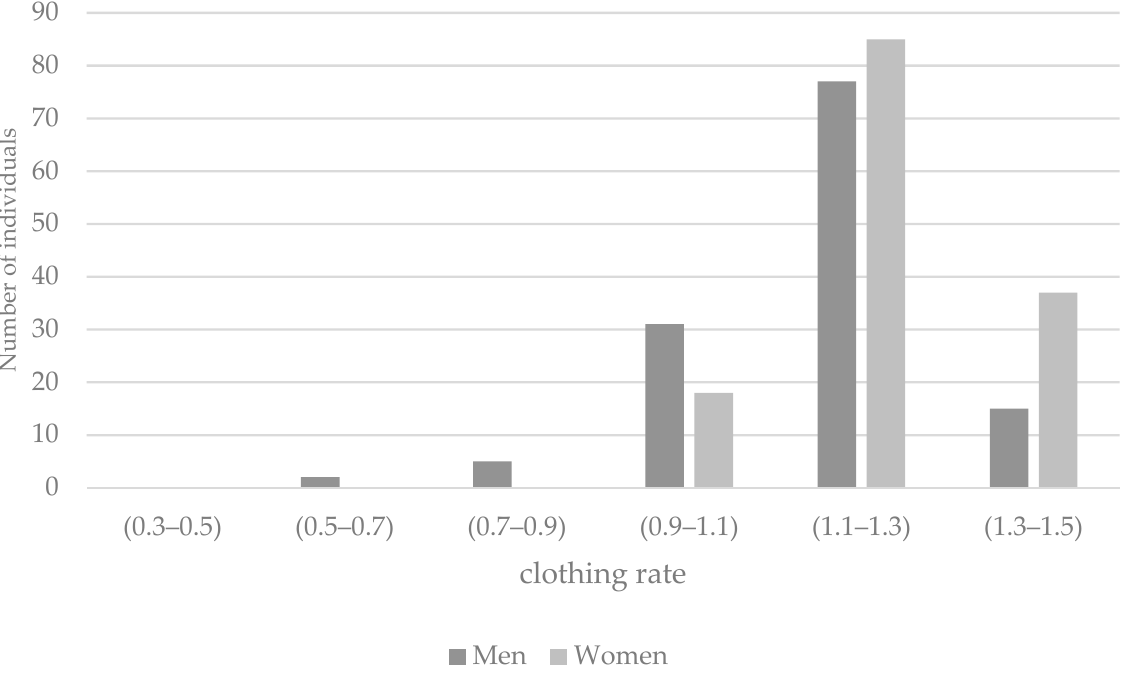
Figure 10. In hot seasons, people adjust their thermal state by various behaviors, such as removing a layer of clothing.